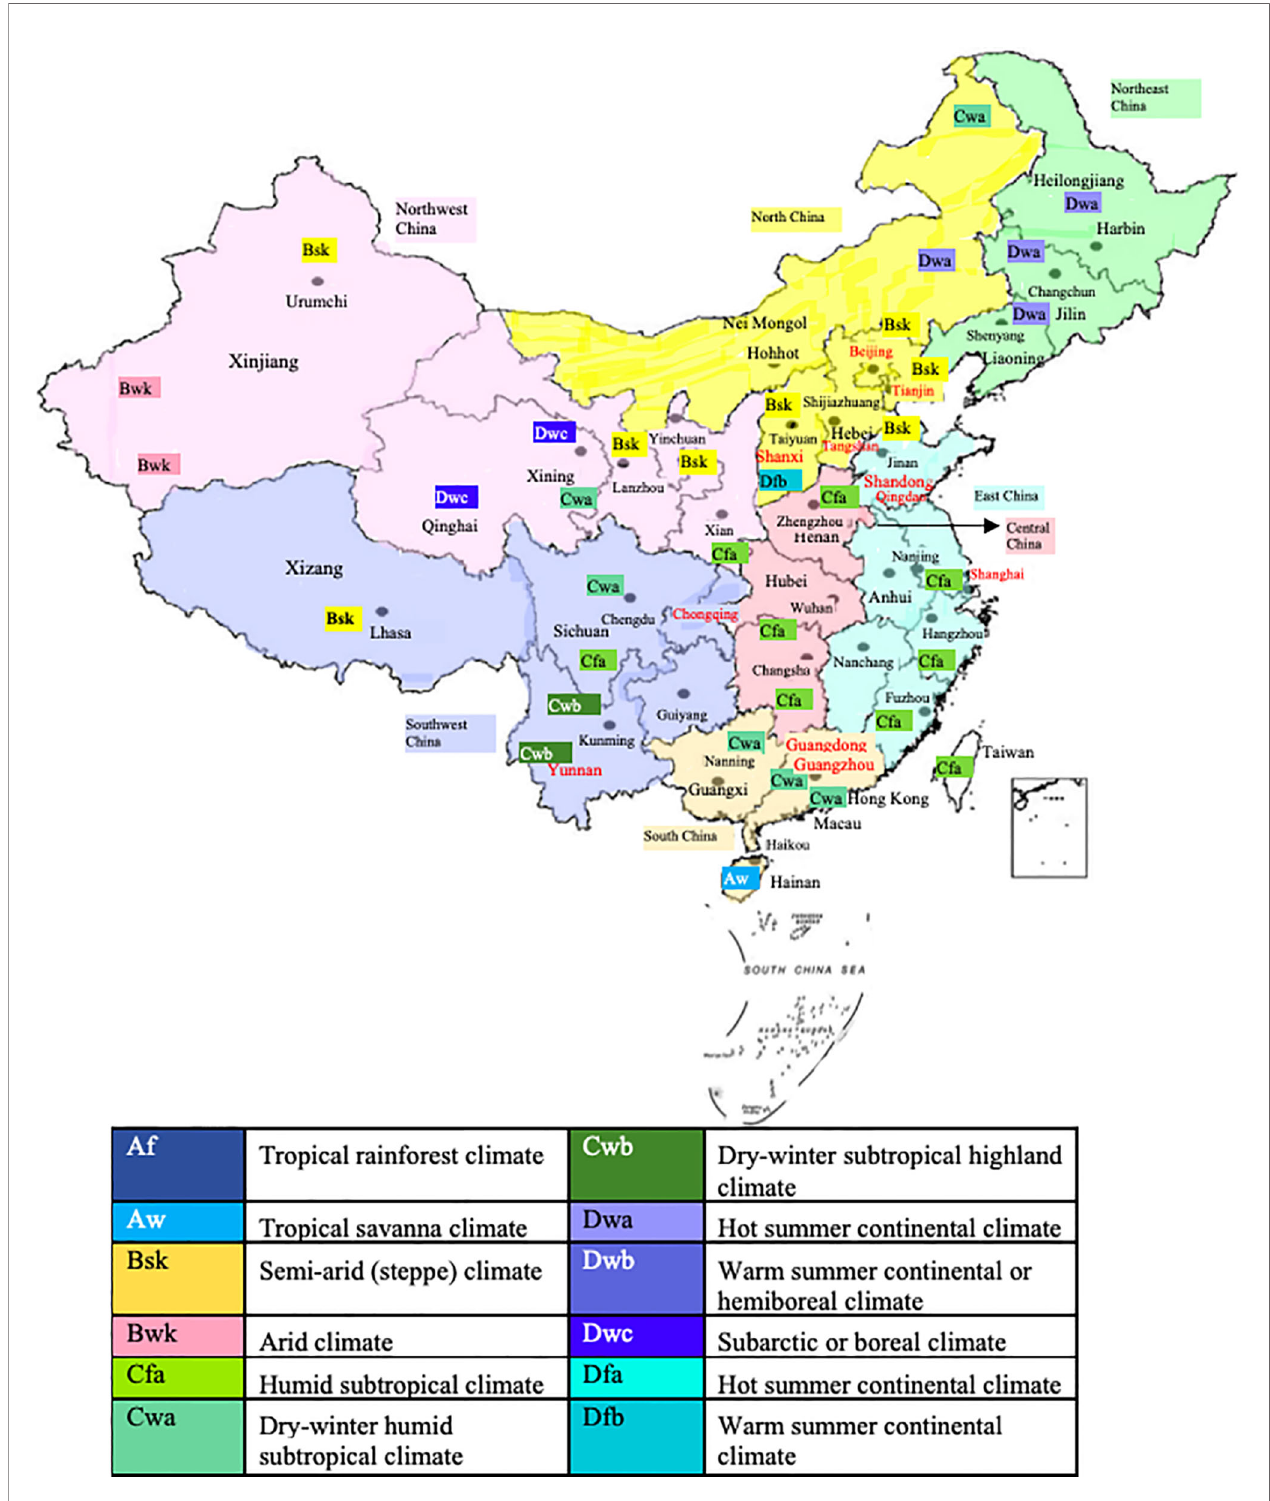
FIGURE 2 | Territories inhabited mainly by a Chinese population and cities/areas for which allergen sensitization data have been obtained. Climate conditions according to the Köppen-Geiger climate classi fi cation system are